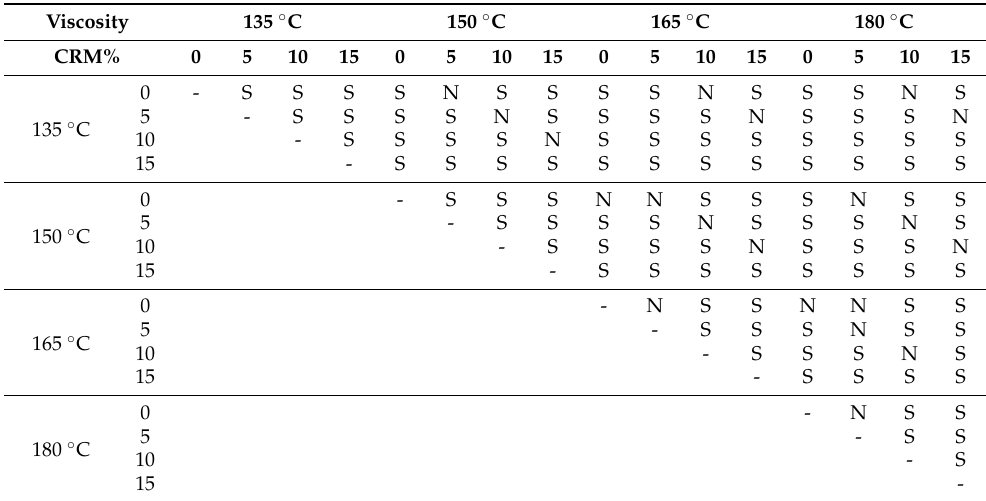
Table 4. Statistical analysis results of viscosity for PG 64-22 with 6% processed oil as a function of CRM content ( α = 0.05).